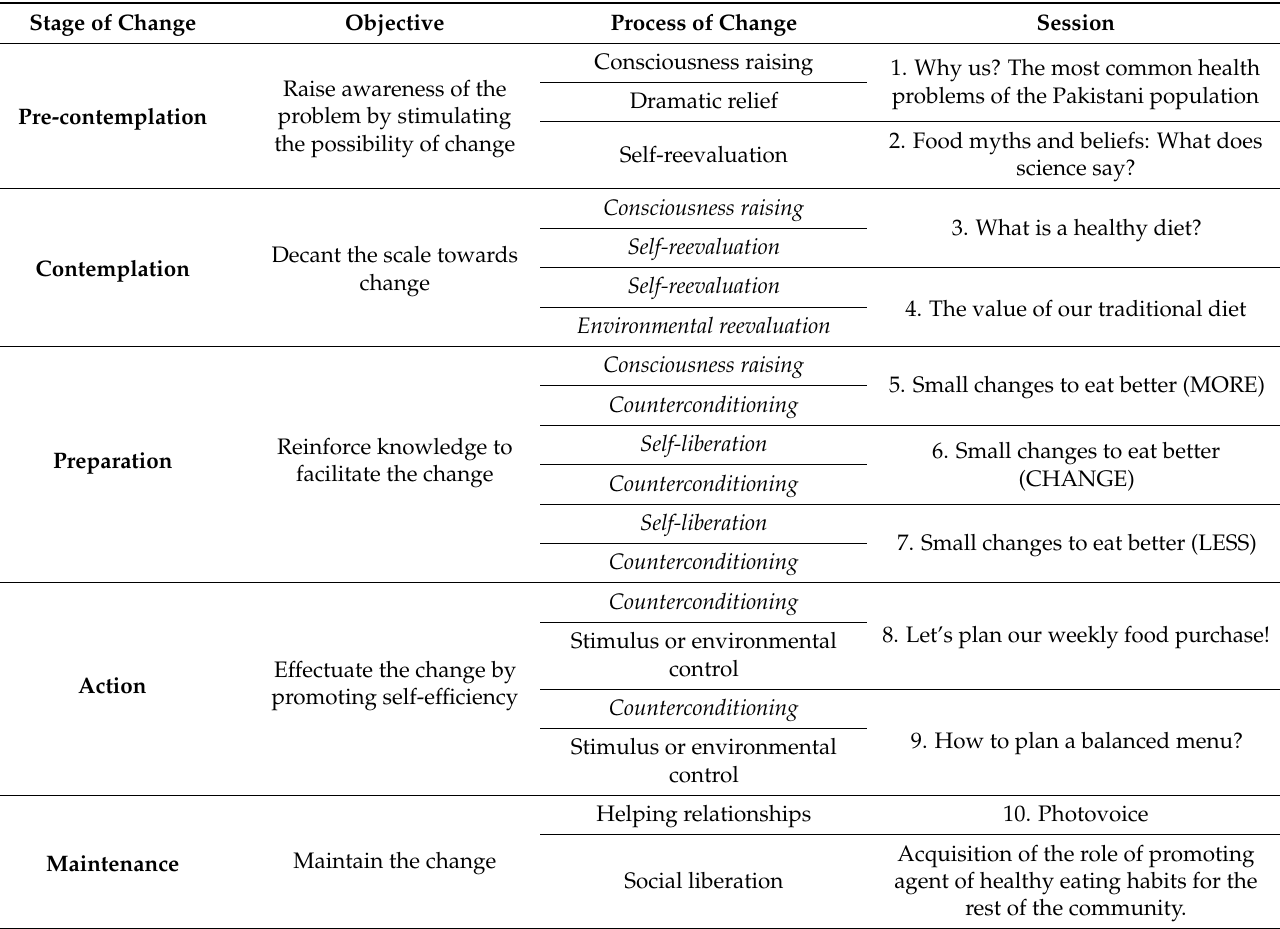
Table 1. Food education sessions based on the Transtheoretical